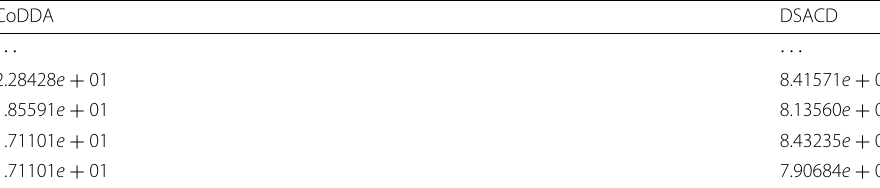
Table 7 Reconstruction error table of CoDDA and DSACD